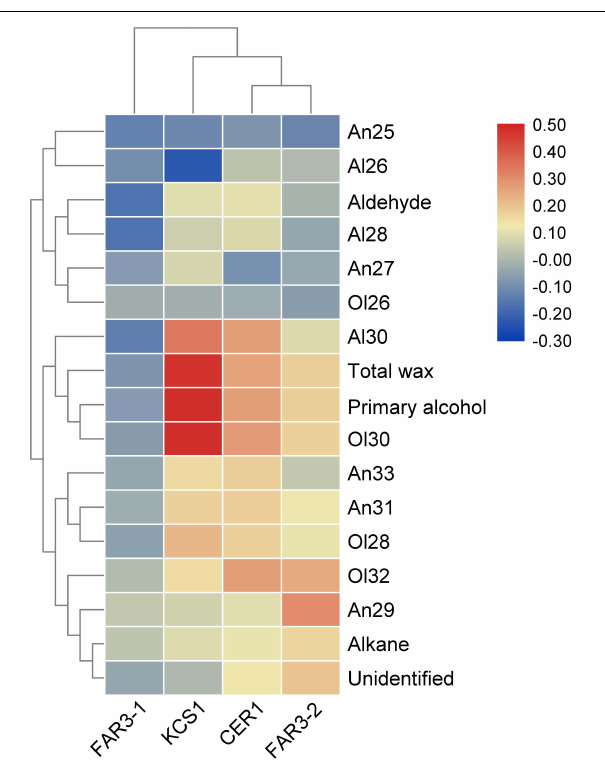
FIGURE 3 | Heatmap of the Pearson’s correlation between cuticular wax and the expression of four genes involved in cuticular wax biosynthesis.